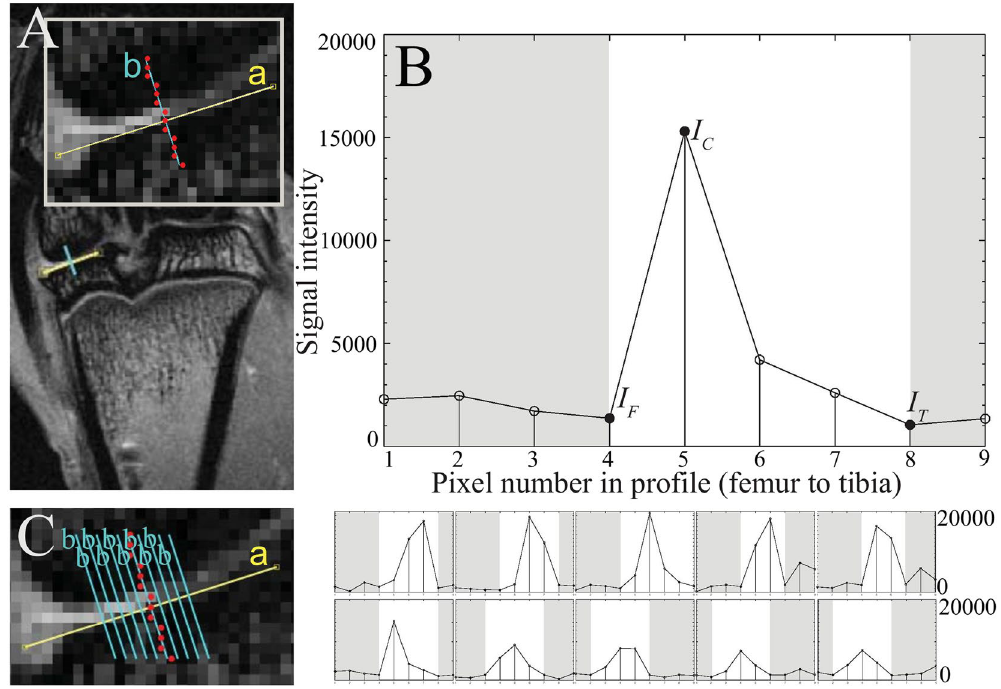
Figure 3. The cartilage thickness measurement procedure shown in a T 2 weighted MR image of a MSX joint at TE = 12 ms ( A ). The straight line bordering AC is shown in yellow and denoted by a. The perpendicular line drawn from femur to tibia, b, is shown in blue in the inset, the nearest voxels of line b are shown in red. The corresponding T 2 profile in ( B ) represents femoral cortical bone in pixel 1–4, cartilage in pixel 5, partial volume of cartilage in pixel 6–8 and tibial cortical bone in pixel 8–9. The partial volume effect observed in pixels 6–8 was corrected by using Eqs (2) and (3). Cartilage thickness was computed by multiplying the total number of voxels representing cartilage with voxel resolution (78 µ m). All of the perpendicular lines b and corresponding T 2 profiles are shown in ( C ). The partial volumes of each profile was corrected as above and a thickness was computed. The mean cartilage thickness was computed by averaging the thicknesses of these intensity profiles.